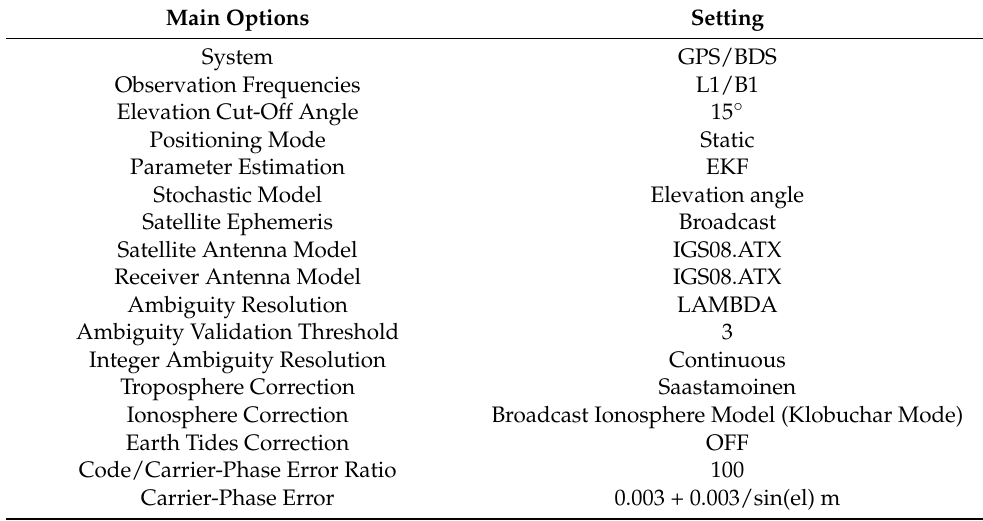
Table 1. Processing strategies and methods of RTKLIB software. GPS: Global Positioning System; BDS: BeiDou Navigation Satellite System; EKF: extended Kalman filter; LAMBDA: least-squares ambiguity decorrelation.